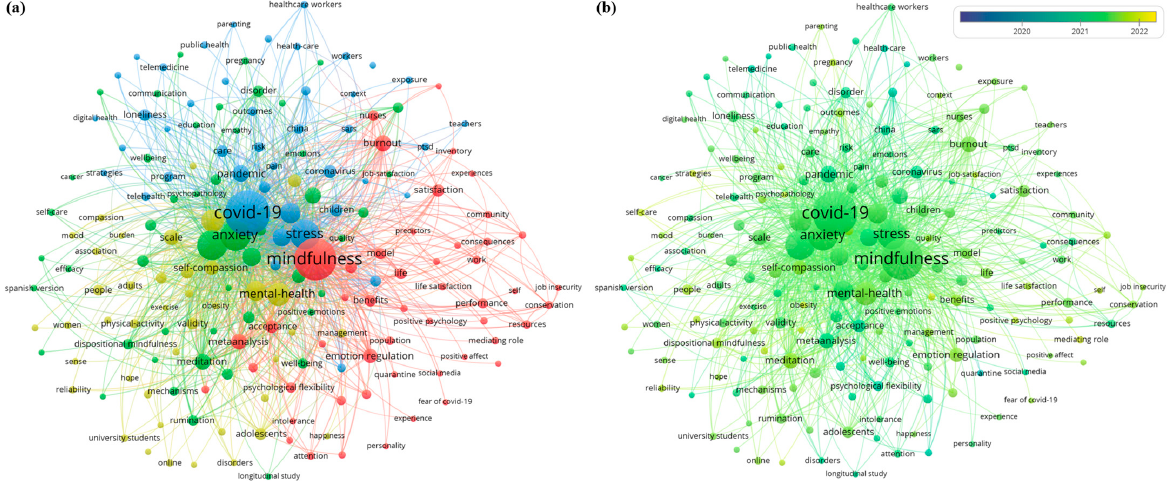
Figure 3. ( a ) Keyword co-occurrence network graph and ( b ) Overlay visualization network graph of mindfulness research topics in the COVID-19 era. Note. Red cluster: mindfulness; Blue cluster: COVID-19; Yellow cluster: mental health; Green cluster: anxiety and depression.